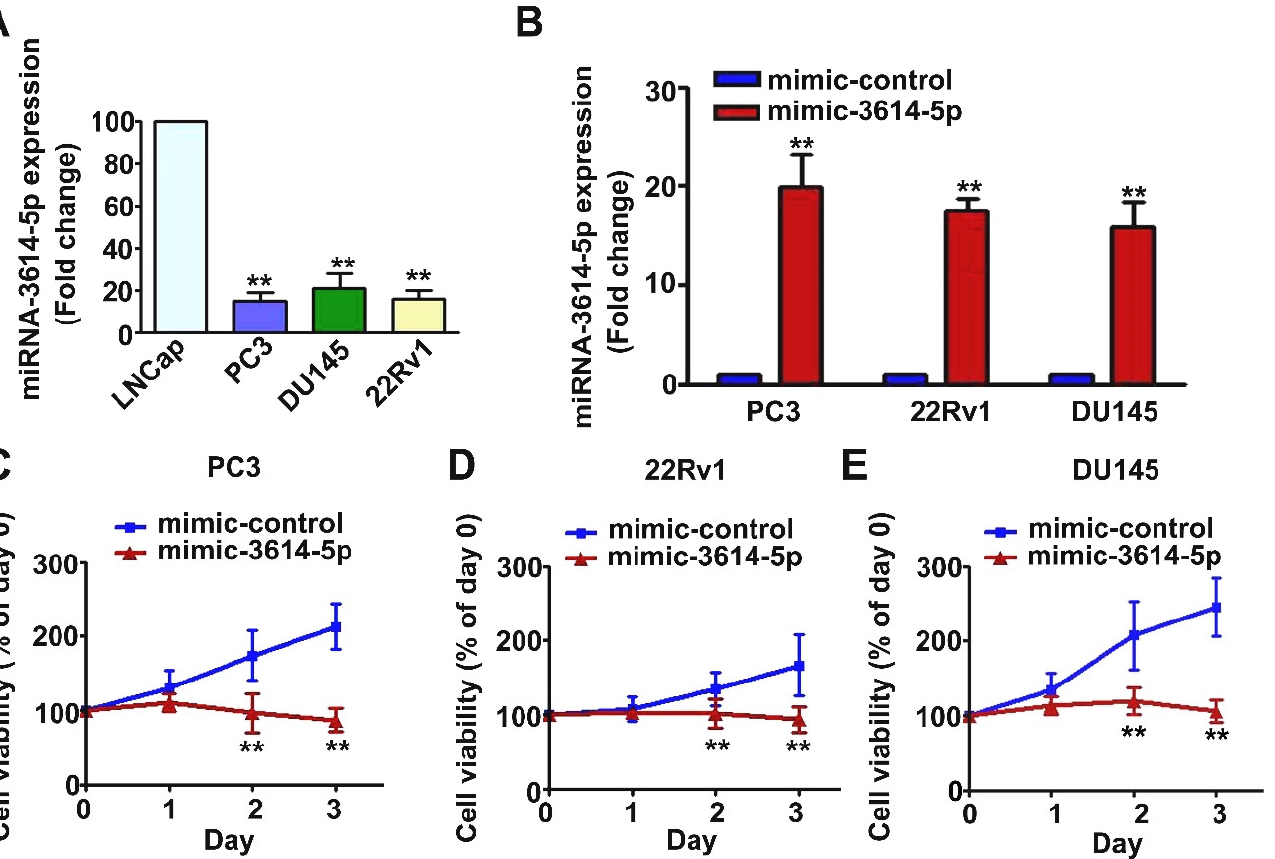
Figure 1. Effect of miRNA-3614-5p on the viability of human prostate cancer cells. ( A ) Endogenous expression of miRNA-3614-5p in human prostate cancer cells including LNCap, PC3, DU145 and 22Rv1 cell lines. ( B ) Exogenous expression of miRNA-3614-5p in human PC3, DU145 and 22Rv1 prostate cancer cell lines transfected with mimic-3614-5p. Cells transfected with mimic-control as the control group. ( C – E ) Cell viability of human PC3, DU145 and 22Rv1 prostate cancer cell lines transfected with mimic-control or mimic-3614-5p for days 1, 2 and 3 were measured using an MTT assay. **, p < 0.01 versus control (mean ± SE, n = 3). mimic-3614-5p as mimic miRNA-3614-5p